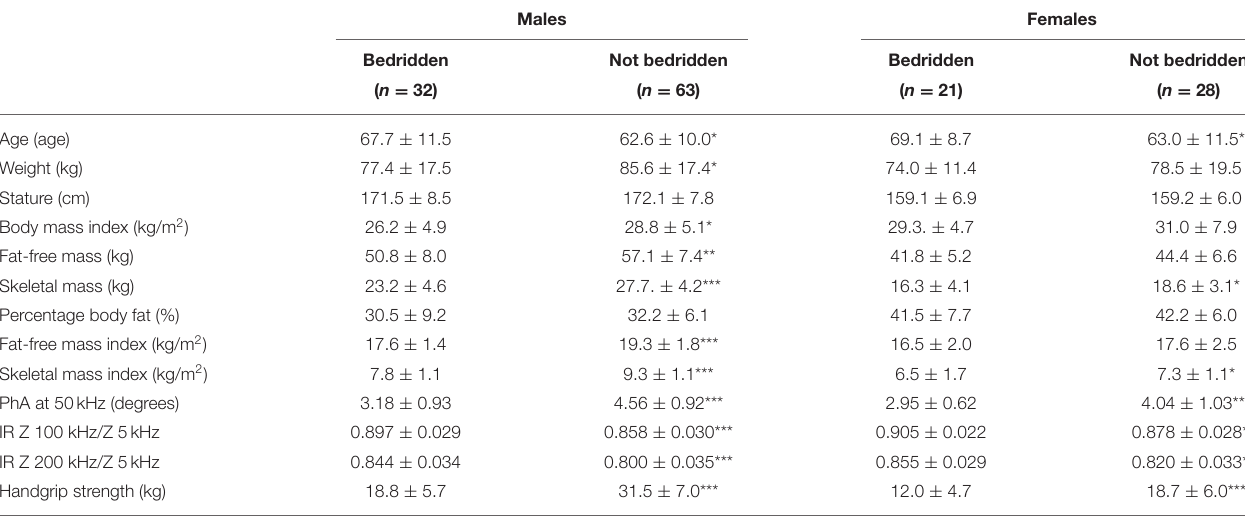
TABLE 3 | Body composition and muscle strength comparison in bedridden vs. not bedridden post-acute COVID-19 patients stratified by sex. Males Females Bedridden Not bedridden Bedridden Not